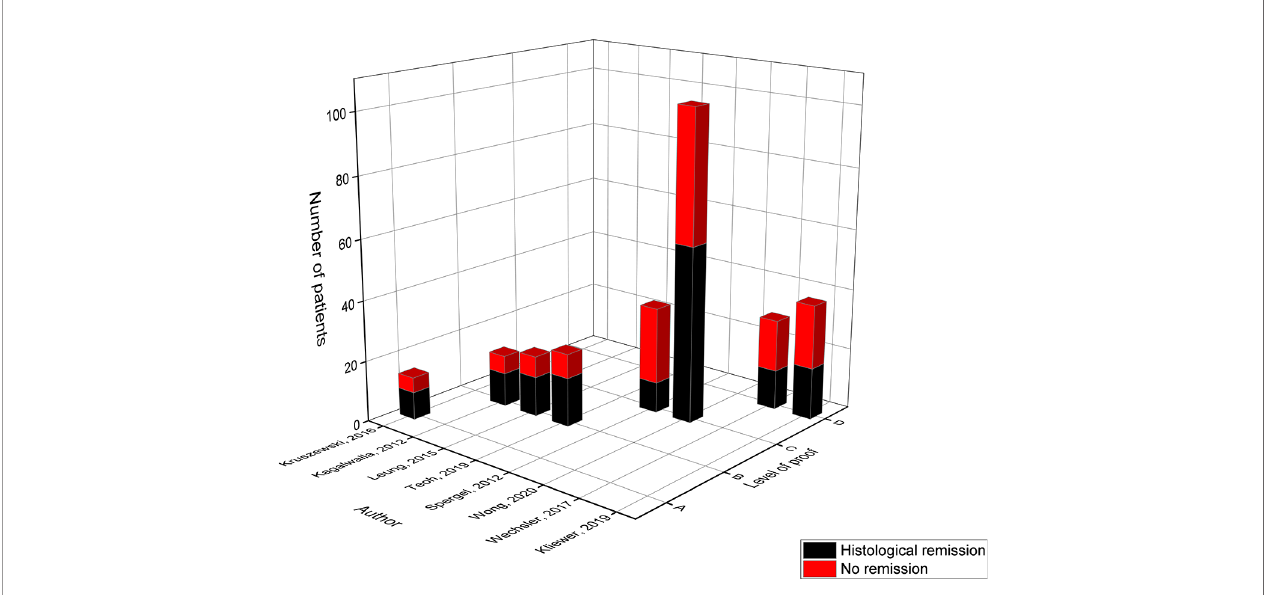
FIGURE 7 | Level of proof of studies on the cow ’ s milk elimination